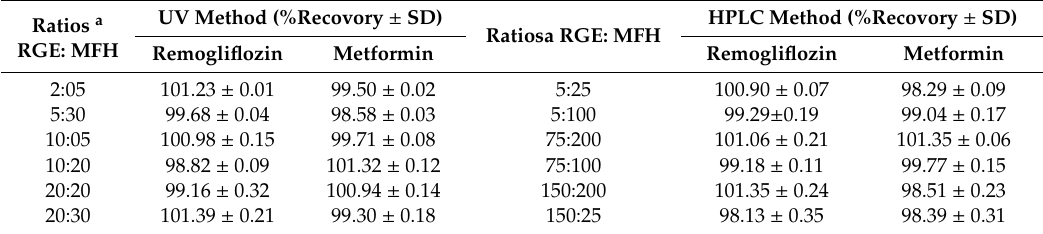
Table 6. Analysis results of laboratory mixed solutions by the proposed methods.